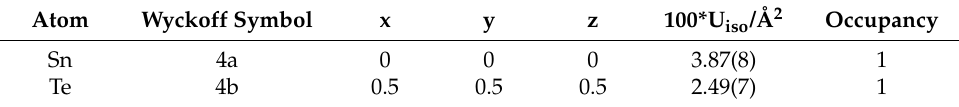
Table 2. Atomic parameters for SnTe nanoparticles synthesised after 2 h boiling.